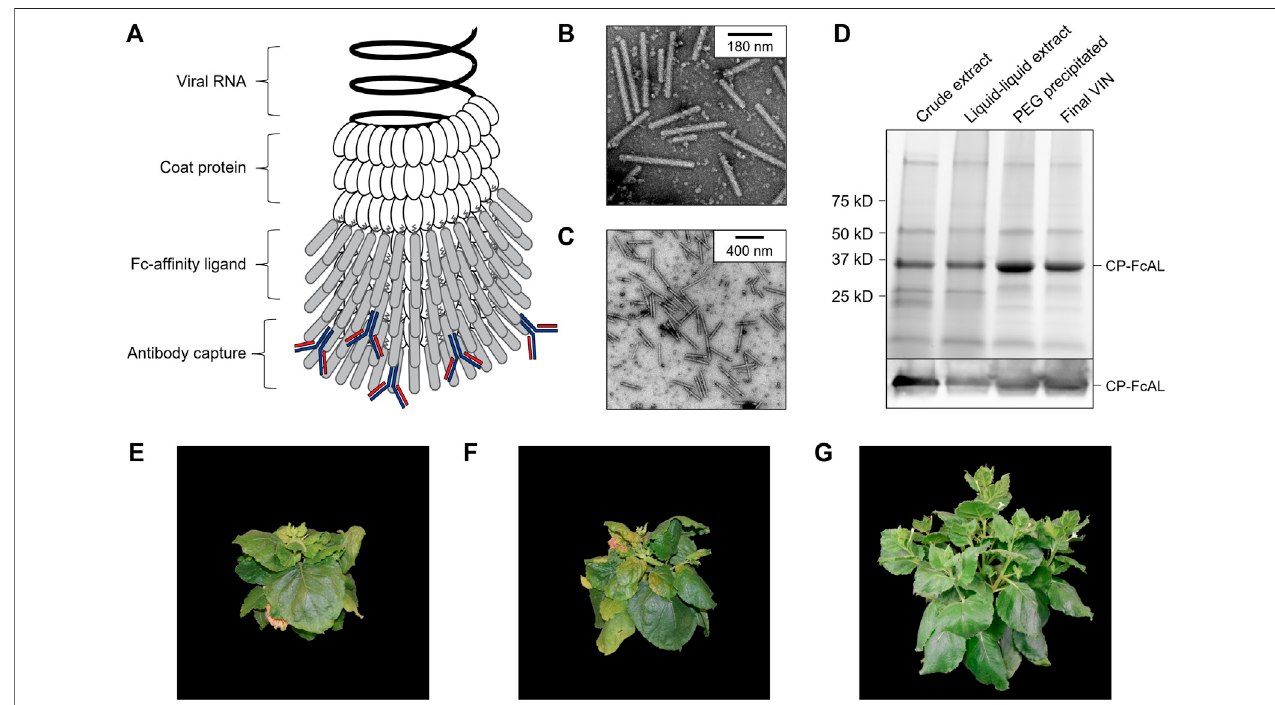
FIGURE 1 | Production of a plant virus-based immunosorbent nanoparticle (VIN). (A) An illustrative depiction of a VIN. The native plant virus (viral nucleic acid encapsulated by coat protein) is fused via a peptide linker to an Fc-af fi nity ligand, which confers immunosorbent functionality to the plant virus. (B,C) Negative stain transmission electron microscope images of VIN in crude plant extract solution produced via agroin fi ltration in N. benthamiana plants. (D) Reducing condition SDS- PAGE (upper) and Western blot (lower) of the VIN preparation marked at the band height corresponding to VIN coat protein Fc-af fi nity ligand fusion (CP-FcAL). Representative photographs from biological triplicates taken with a consistent frame of reference of 7-week-old N. benthamiana plants incubated in a controlled environment facility for 14 days post-infection with mechanically transmitted (E) VIN (produced using vector pICH25892), and (F) wild-type tobacco mosaic virus, as compared to (G) uninfected healthy